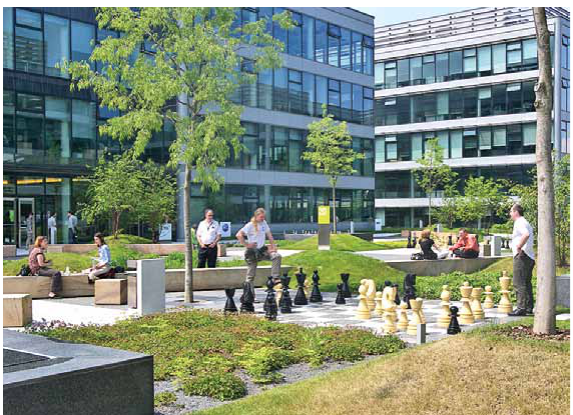
fig. 9. Cigler Marani architects: The Park, Prague,